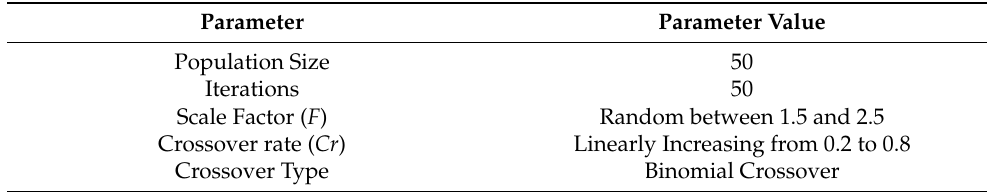
Table 2. The setting of DE parameters.